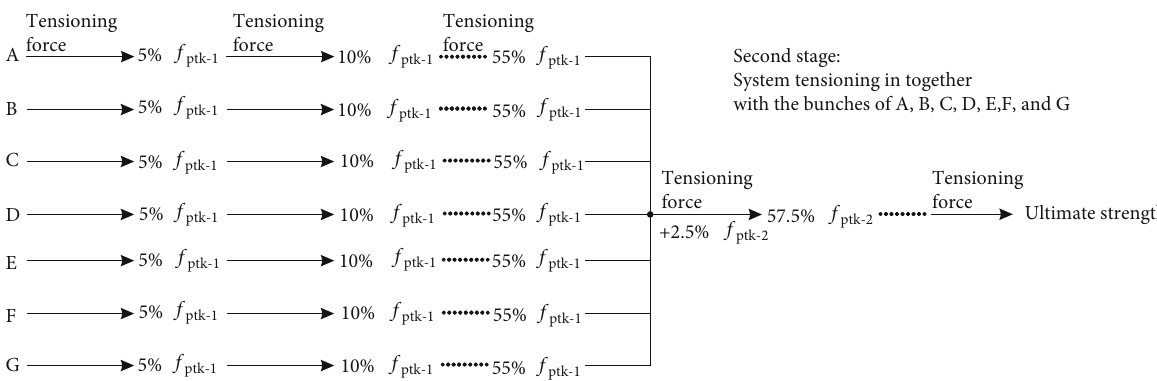
Figure 6: The tensioning procedure for the ultimate strength test of this developed large-tonnage BFRP cable anchor.